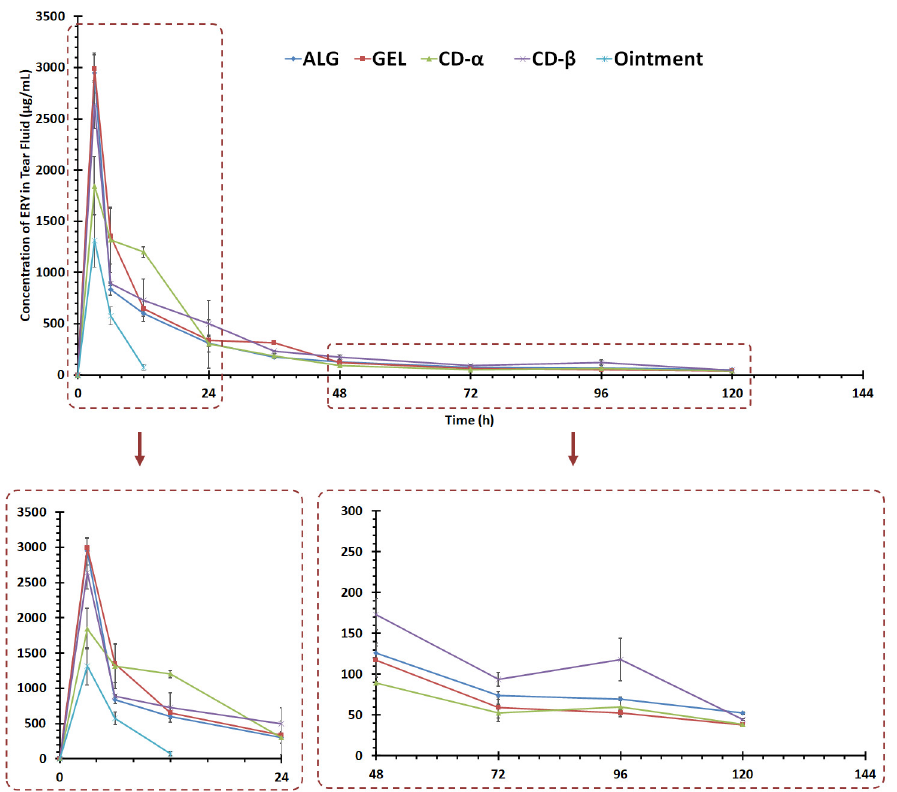
Figure 7. ERY concentration in tear fluid following administration of marketed ophthalmic ointment of erythromycin, ALG, GEL, CD-α, and CD-β ocular inserts ( n = 30). Table 6. The pharmacokinetic parameters of ERY-loaded ocular inserts tested in the rabbits’ eyes ( n =